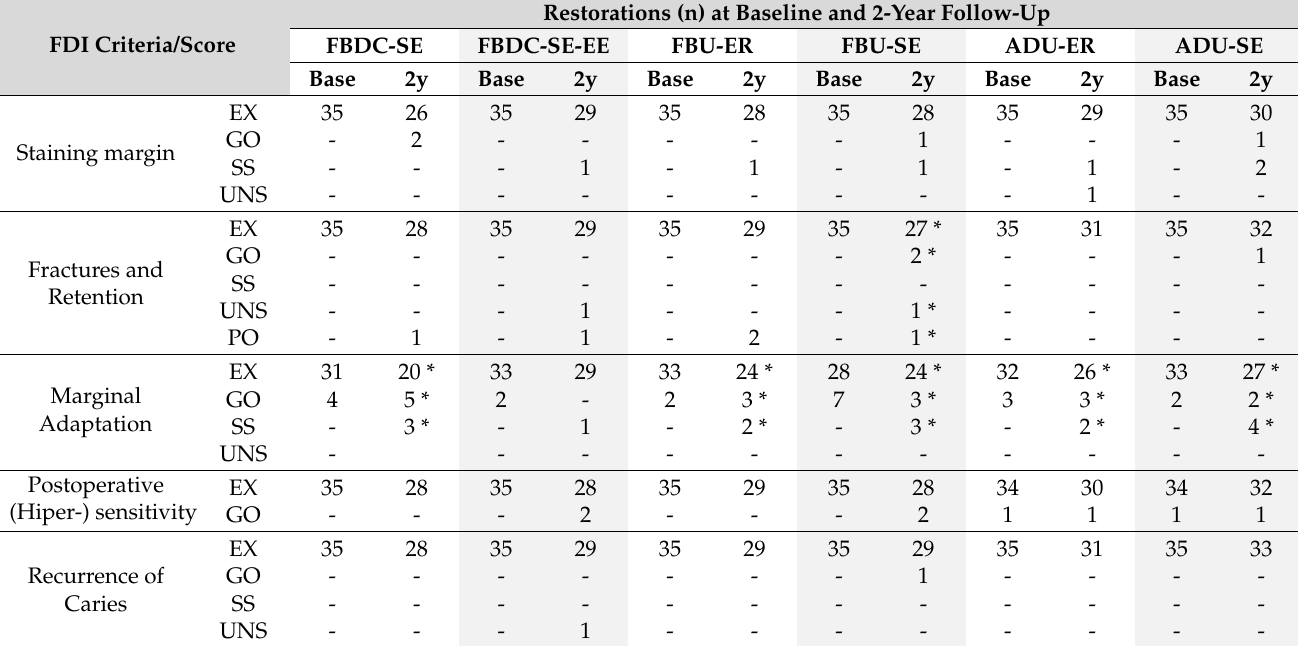
Table 3. Clinical evaluation by FDI criteria of NCCL restorations’ distribution (number) per